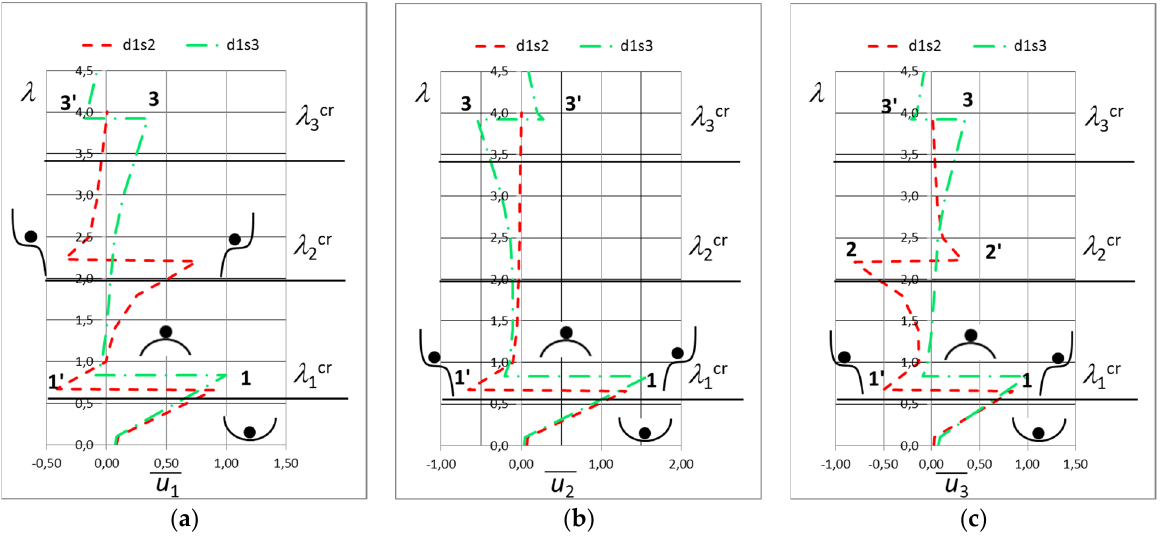
Figure 16. Equilibrium path obtained for geometrical imperfections in the shape of: large amplitude of the first buckling mode, medium amplitude of the second or third buckling mode, respectively ( d 1 s 2 or d 1 s 3); displacement of the node: ( a ) No. 1, ( b ) No. 2, ( c ) No. 3.